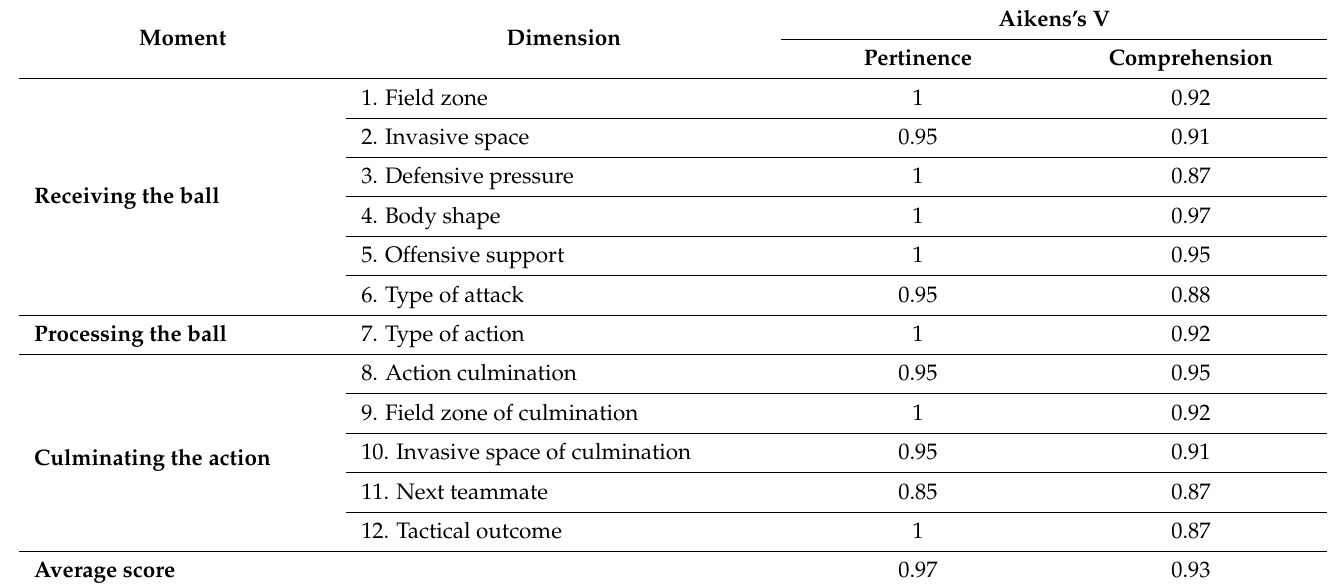
Table 5. Values of content validity (Aikens’s V) of the dimensions that form the INDISOC observa- tional tool.